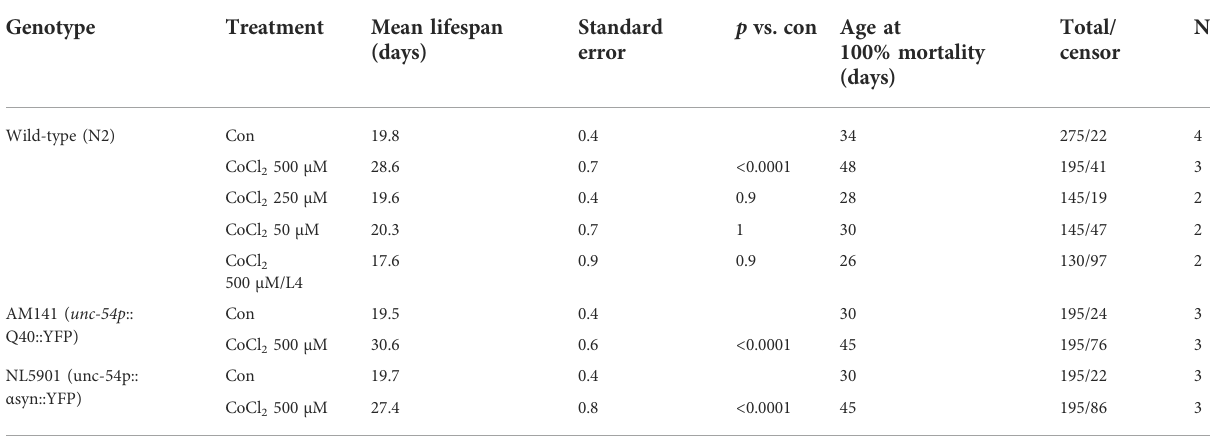
TABLE 1 Summary of lifespan